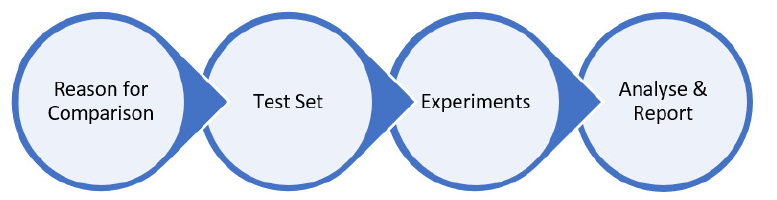
Figure 3. Comparing methodology phases.